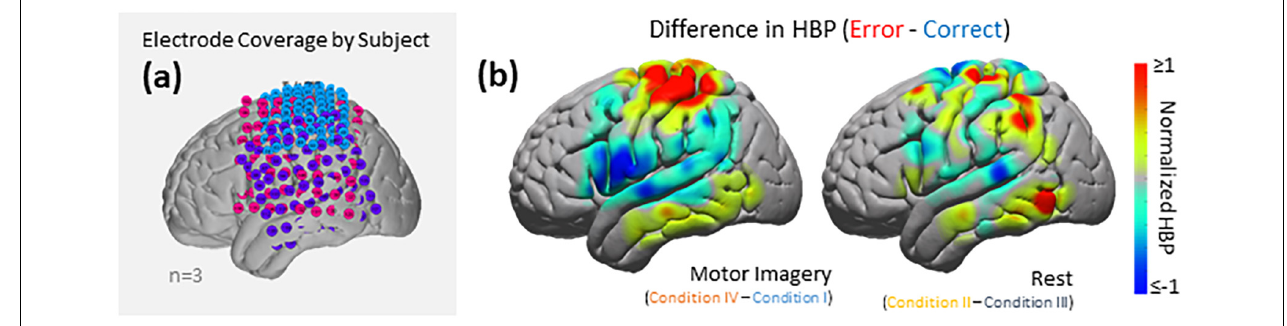
FIGURE 6 | HBP during correct and erroneous BCI decoder performance. (a) Electrode coverage by subjects in the left ( n = 3), separated by color (Subject 1 in blue, Subject 2 in purple, Subject 3 in pink). (b) Difference in high-gamma power during correct and error epochs 100–500 ms after error onset. Left shows power of Condition IV–Condition I, right shows power of Condition II–Condition III. Heat maps were scaled to visualize the most robust